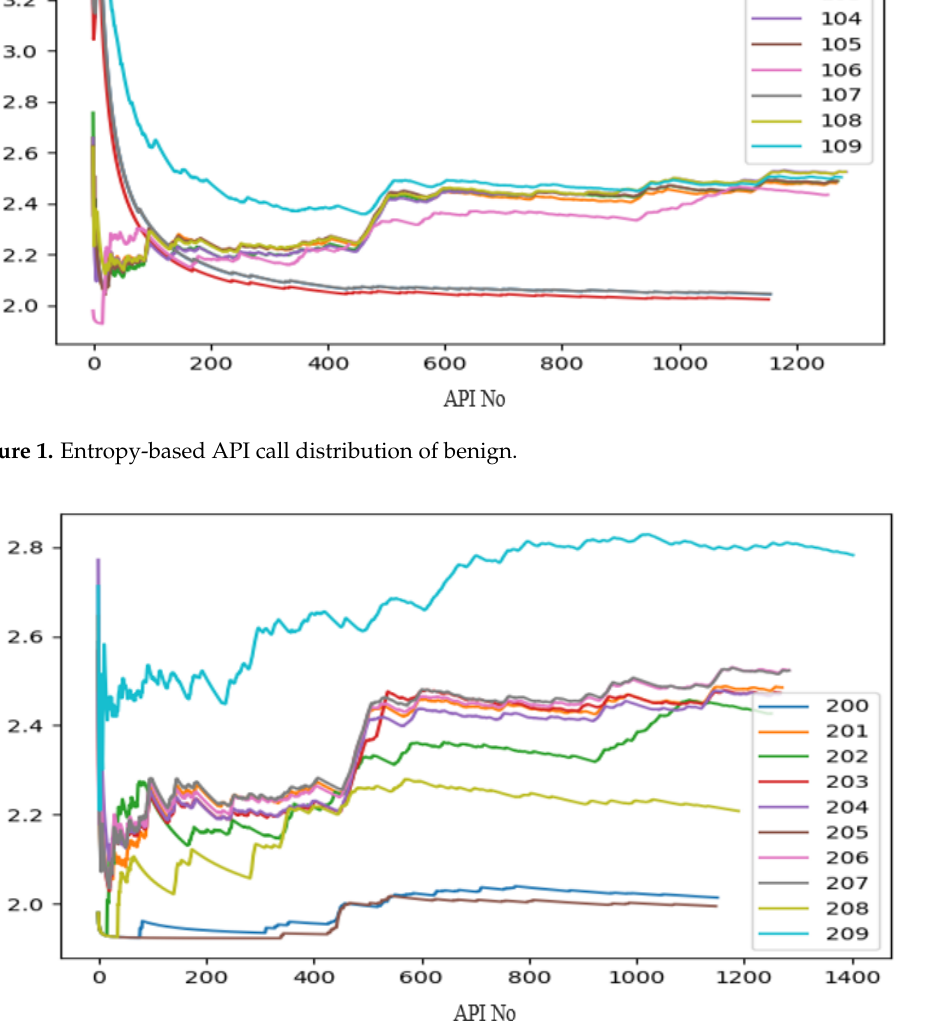
Figure 2. Entropy-based API call distribution of malware.